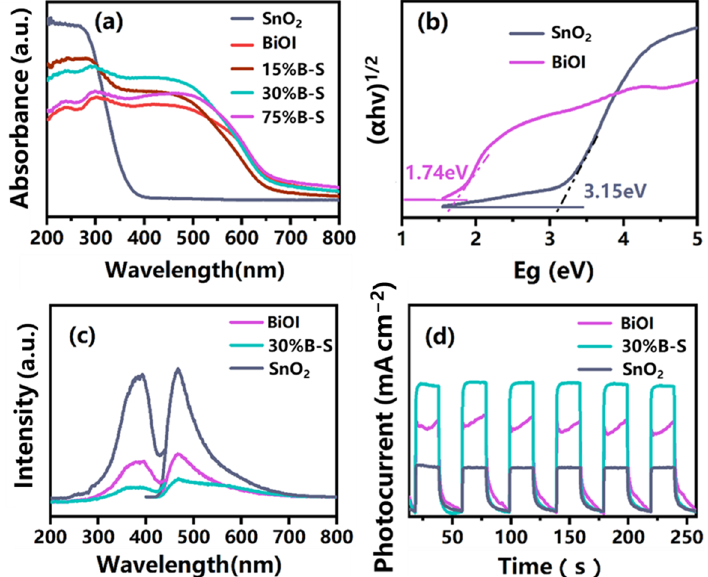
Figure 6. ( a ) UV-vis diffuse reflectance spectra (UV-vis DRS) of prepared samples, ( b ) plot of ( α hv ) 1/2 versus light energy ( hv ) for BiOI and SnO 2 , ( c ) photoluminescence spectra (PL), and ( d ) photocurrent density of BiOI, SnO 2 , and 30%B-S.